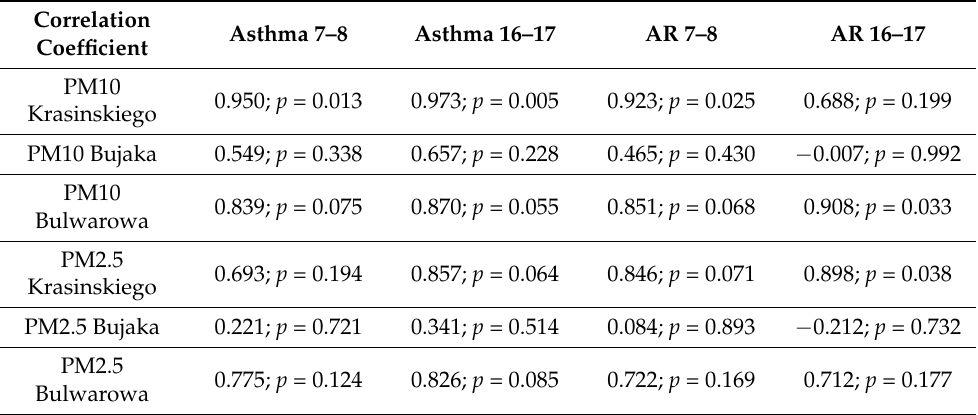
Table 2. Analysis of the correlation between the diagnosis of asthma and allergic rhinitis and the concentration of PM 10 and PM2.5 in the studied years.